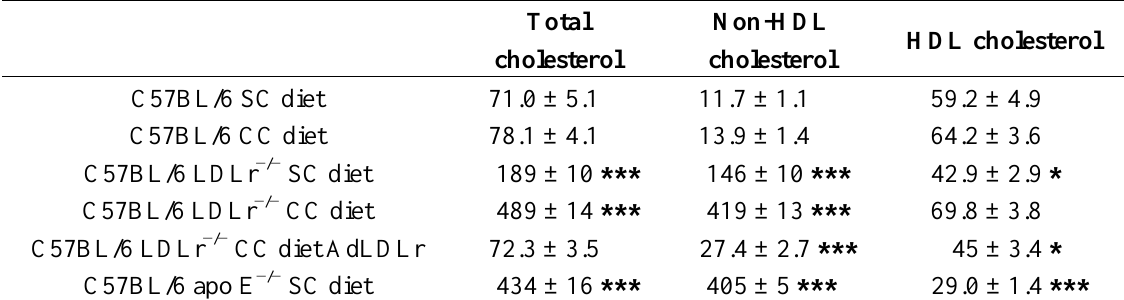
Table 1. Total, non-HDL, and HDL cholesterol levels (mg/dl) in murine plasma at the time of wound creation.